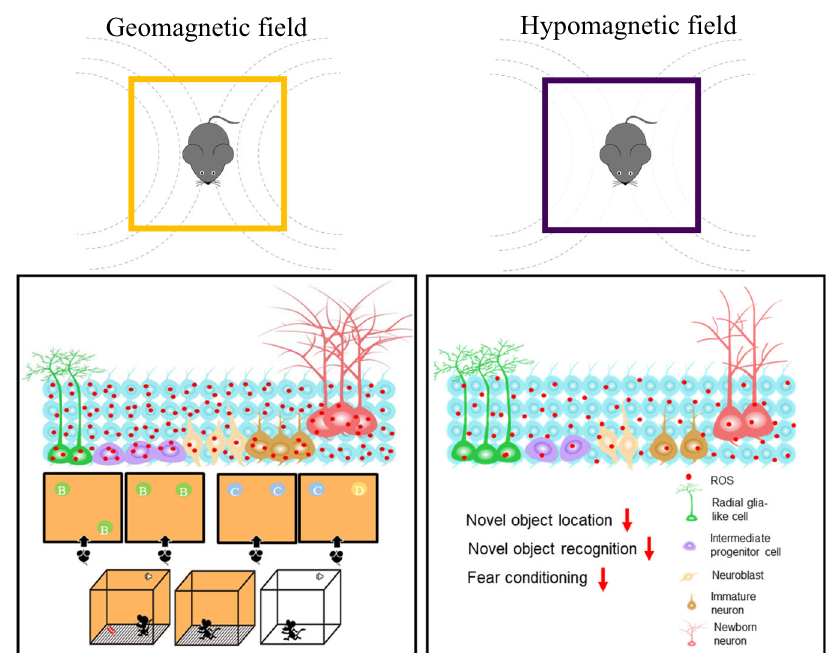
Fig. 8 Working model illustrating the effects of GMF and HMF on adult hippocampal neurogenesis. GMF regulates hippocampal neurogenesis and hippocampus-dependent learning through maintaining proper endogenous ROS levels (red dots). However, HMF attenuates hippocampal neurogenesis and hippocampus-dependent learning by reducing endogenous ROS